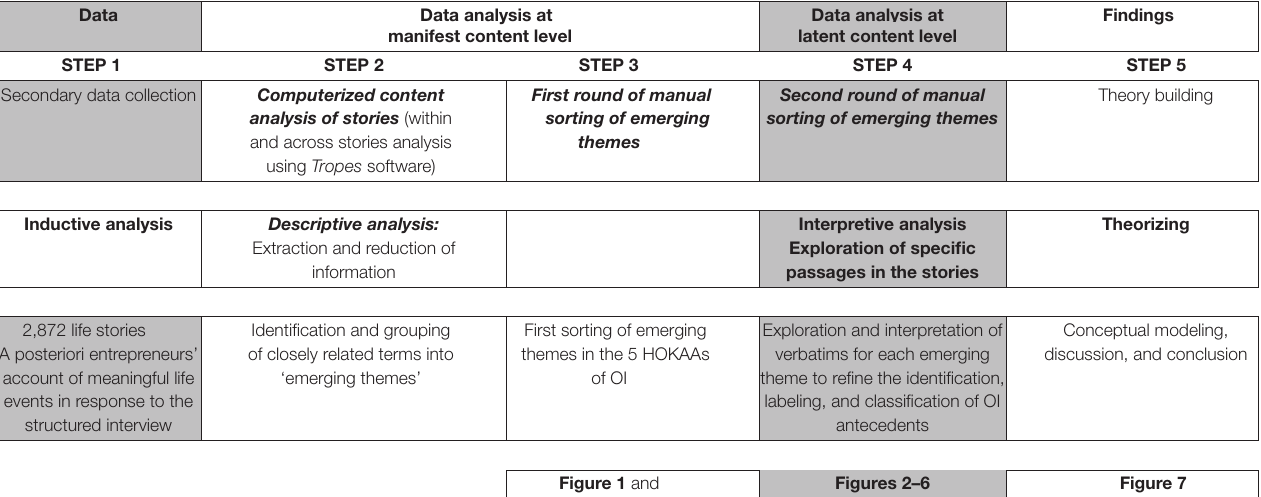
TABLE 1 | Five-step process of the content